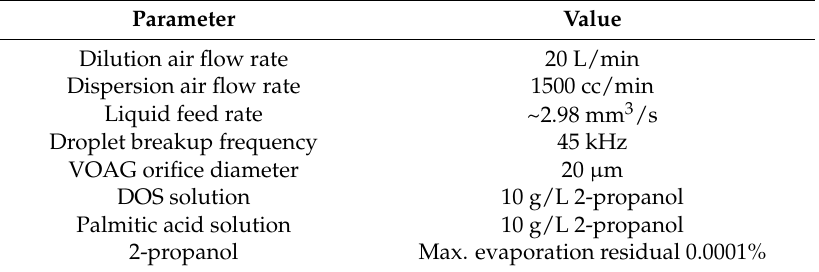
Table 2. The Vibrating Orifice Aerosol Generator (VOAG)